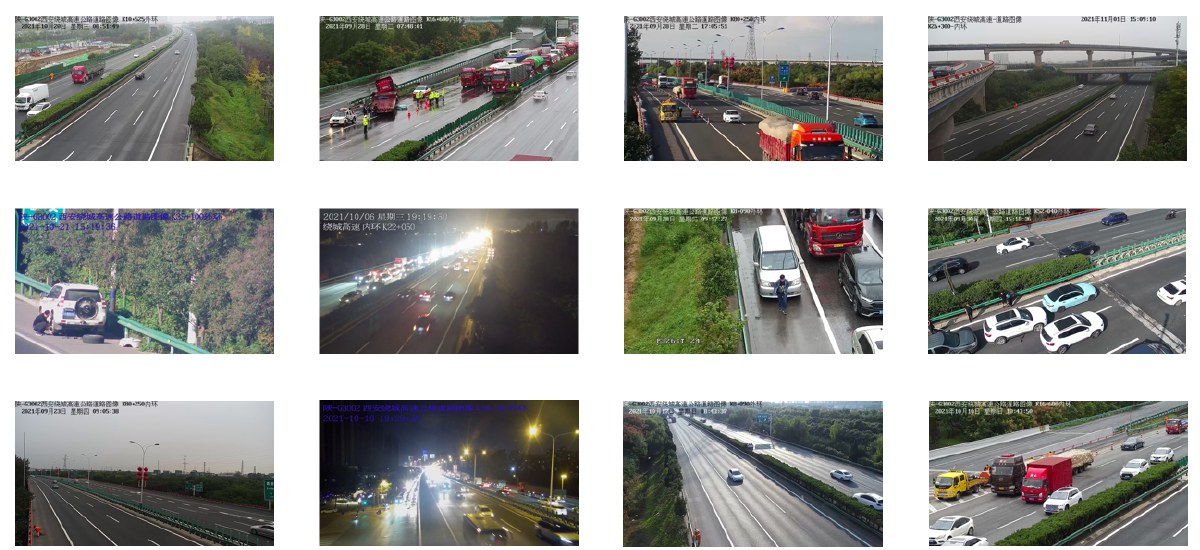
Figure 3. The datasets containing various traffic scenes with a total of approximately 100,000 images. (The Chinese words in the image are the time and place recorded by the surveillance